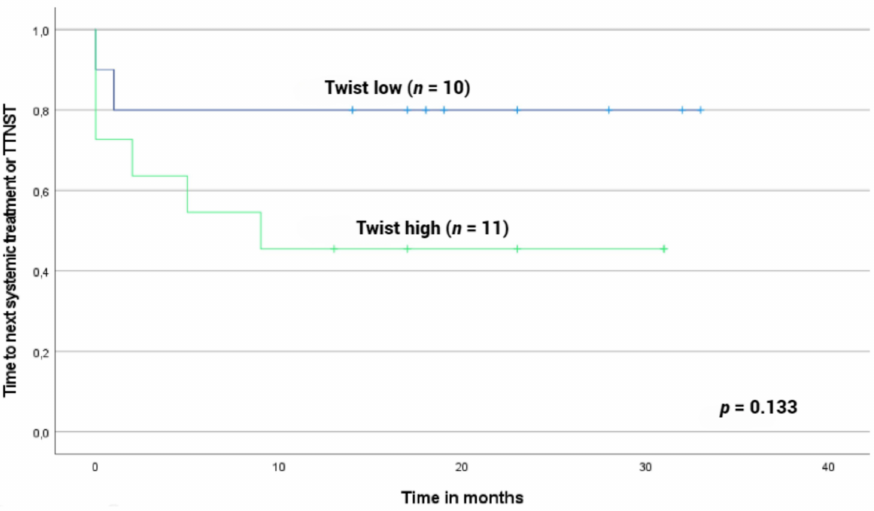
Figure 1. Time to systemic therapy (TTST) based on Twist1 nuclear expression in MF patient samples. TTST was evaluated from confirmed diagnosis date to beginning of systemic therapy or last follow- up date. The cut-off value for Twist1 was 17.6% and cases were divided into two groups based on expression results: Twist1 low <17.6% ( n = 10) and Twist1 high ≥ 17.6% ( n = 11). Patients with high nuclear Twist1 expression were associated with shorter TTST and required systemic treatments earlier ( p value =